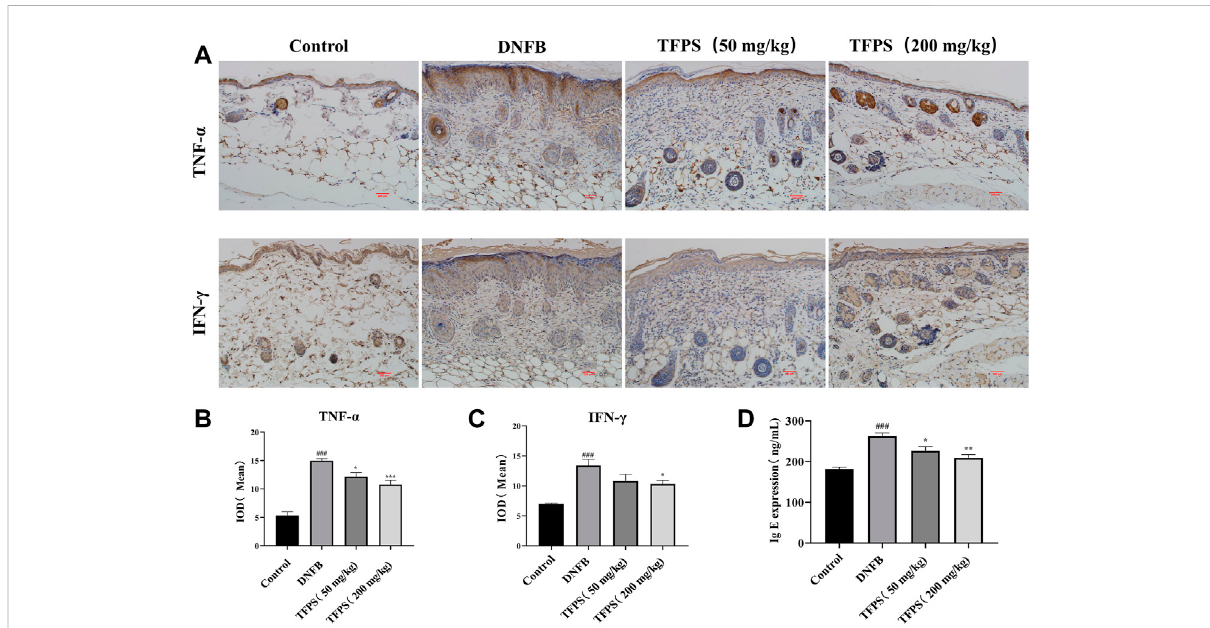
FIGURE 4 Effect of oral administration of TFPS on cytokine expression in the dorsal skin of AD mice. (A) The IHC results of TNF- α and IFN- γ in kidney of Control, DNFBandTFPS(50or200 mg/kg)groups(magni fi cation×200) (B) MeanIODofTNF- α group. (C) MeanIODofIFN- γ IHCineachgroup. (D) Determination of serum IgE level in each test group. All values are represented as means ± S.E.M ( n = 3). ### p < 0.001, compared with Control group. p p < 0.05, pp p < 0.01, ppp p < 0.001, compared with DNFB group.